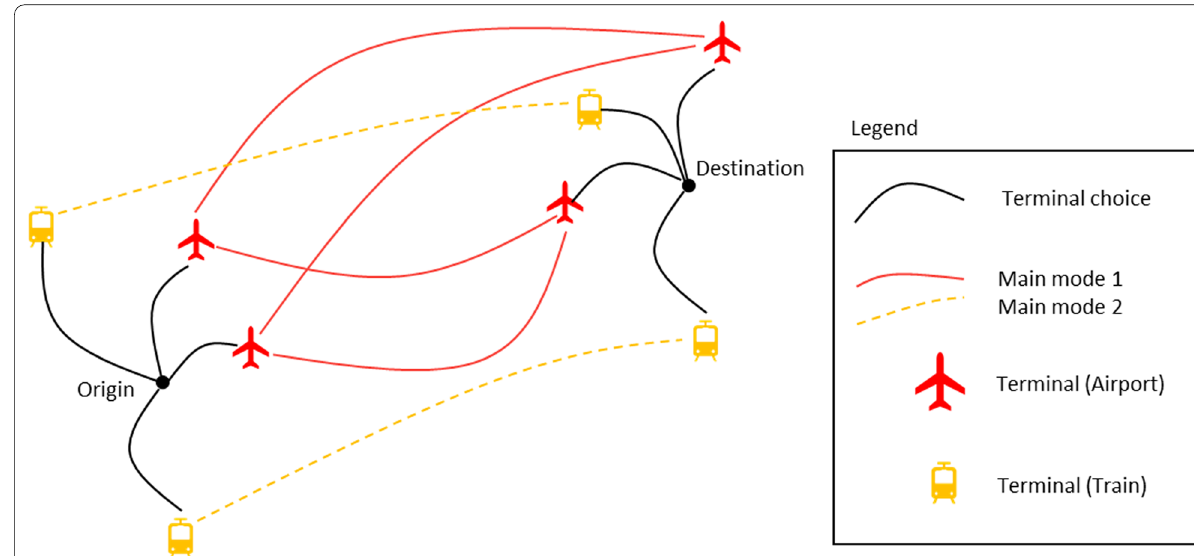
Fig. 5 Schematic figure of terminal choice within main mode choice (Type